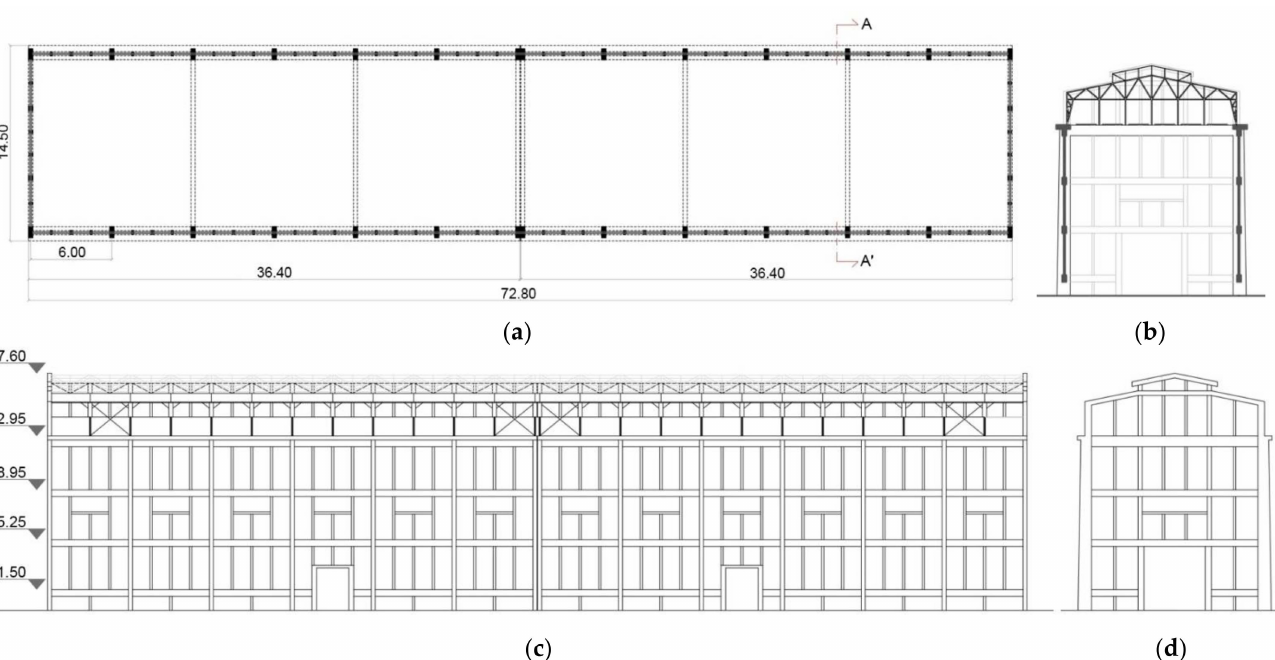
Figure 2. The former tobacco factory in Cervinara: ( a ) fourth-floor plan; ( b ) transverse section A–A’; ( c ) south side; ( d ) east